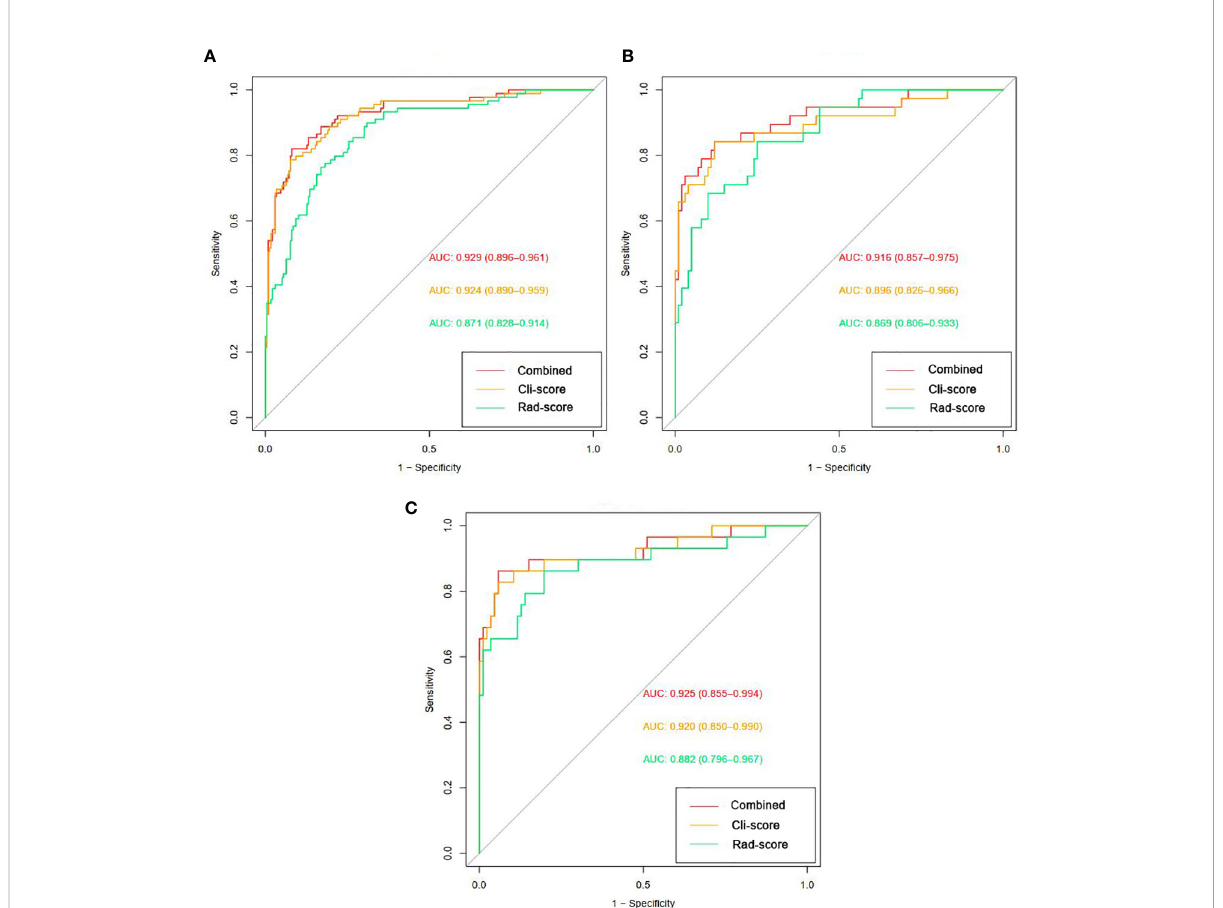
FIGURE 5 Diagnostic performance of the clinical factors model, radiomics signature, and radiomics nomogram was assessed and compared through ROC curves in the training (A) , internal validation (B) and external validation (C) cohorts. ROC = receiver operating characteristics; AUC = area under the receiver operating characteristic curve.